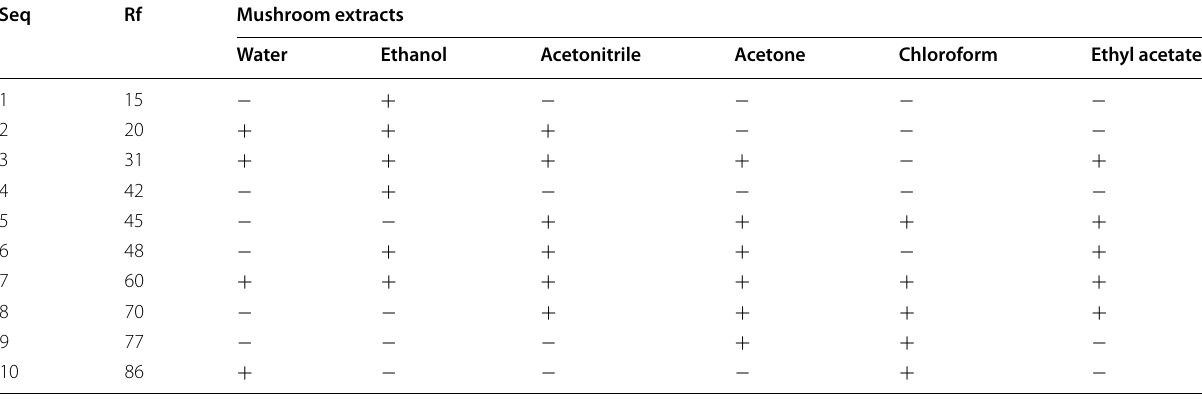
Table 7 Preliminary identification and distribution of the subcomponents of the crude extracts by a fully automated HPTTLC scanner Seq